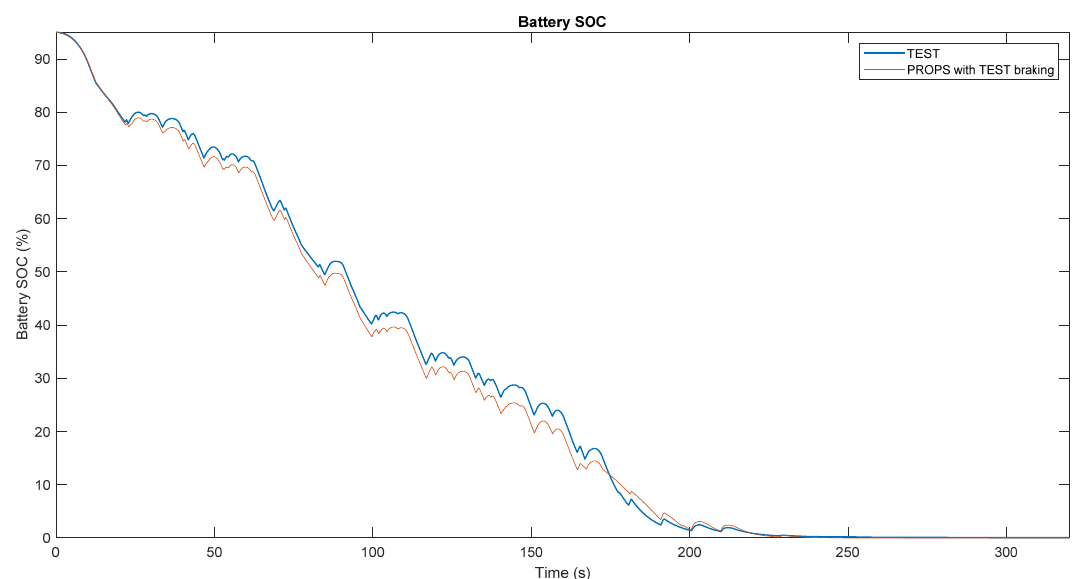
Figure 21. TEST (in blue) and PROPS (in red) battery SOC (in percentage) vs. Lap Time (in seconds).